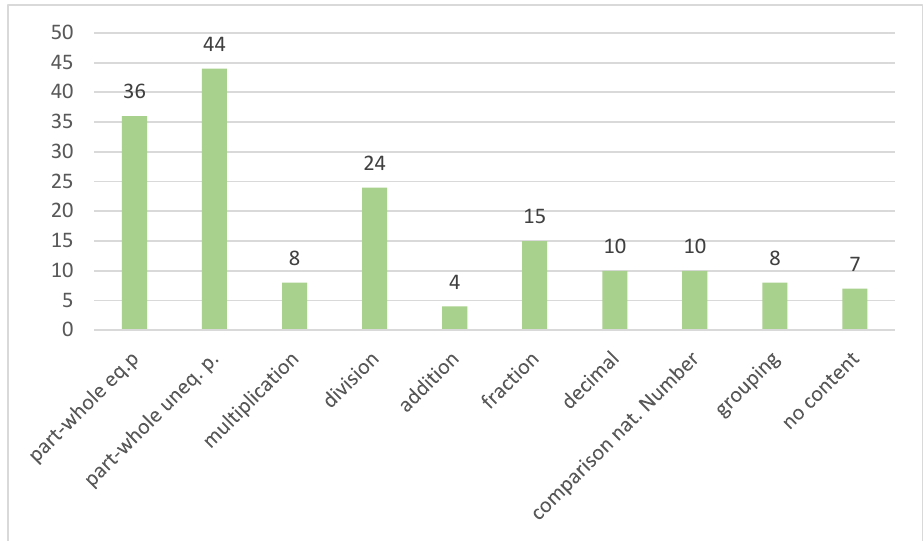
Figure 7. Frequency of use of each content.